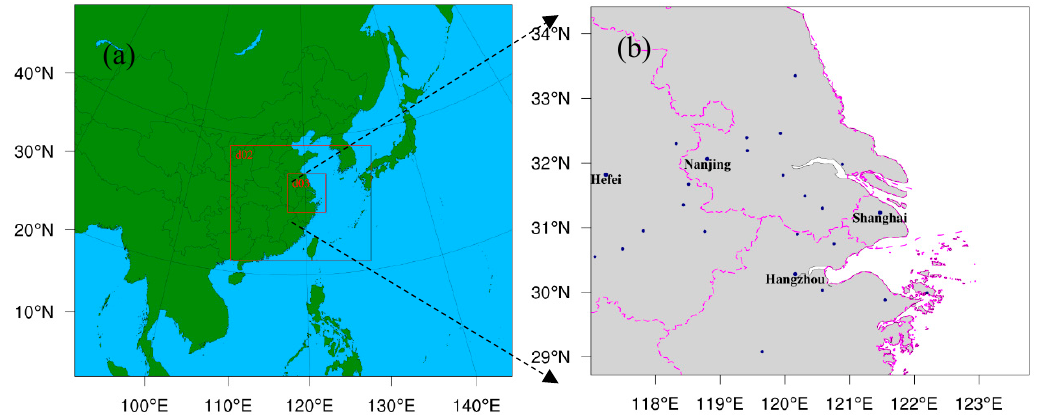
Figure 1. The simulation domain settings in WRF-Chem, including ( a ) the three nested domains and ( b ) the details of domain 3 that mainly covers the Yangtze River Delta (YRD) region.